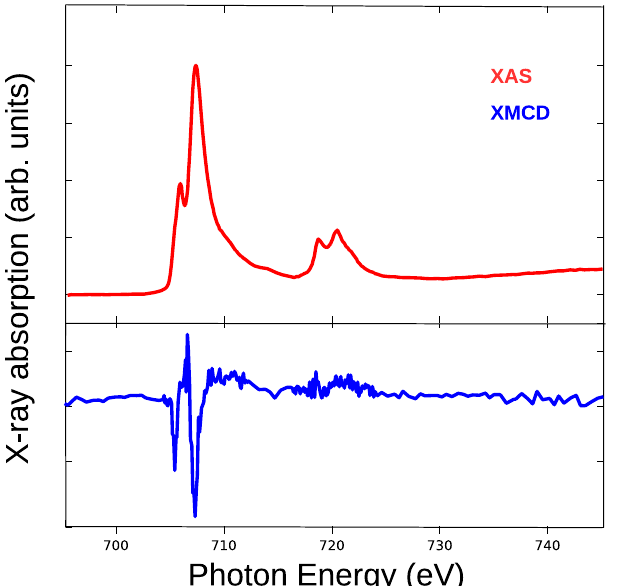
Figure 11. Fe XAS and XMCD spectra acquired from the black domain in the platelets shown in Fig. 10b by